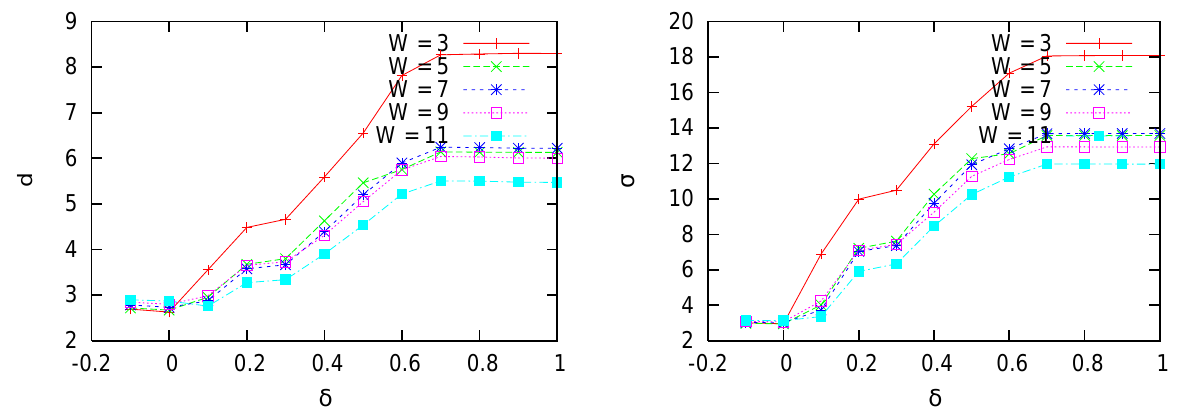
Figure 18. Error and standard variation for the Corridor images.